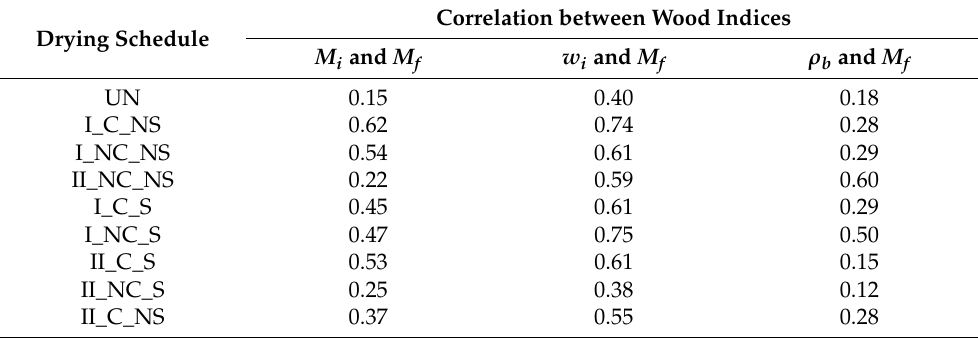
Table 5. The correlation between M f and initial wood indices in nine drying runs (abbreviated names of the drying schedules are defined in Table 1).